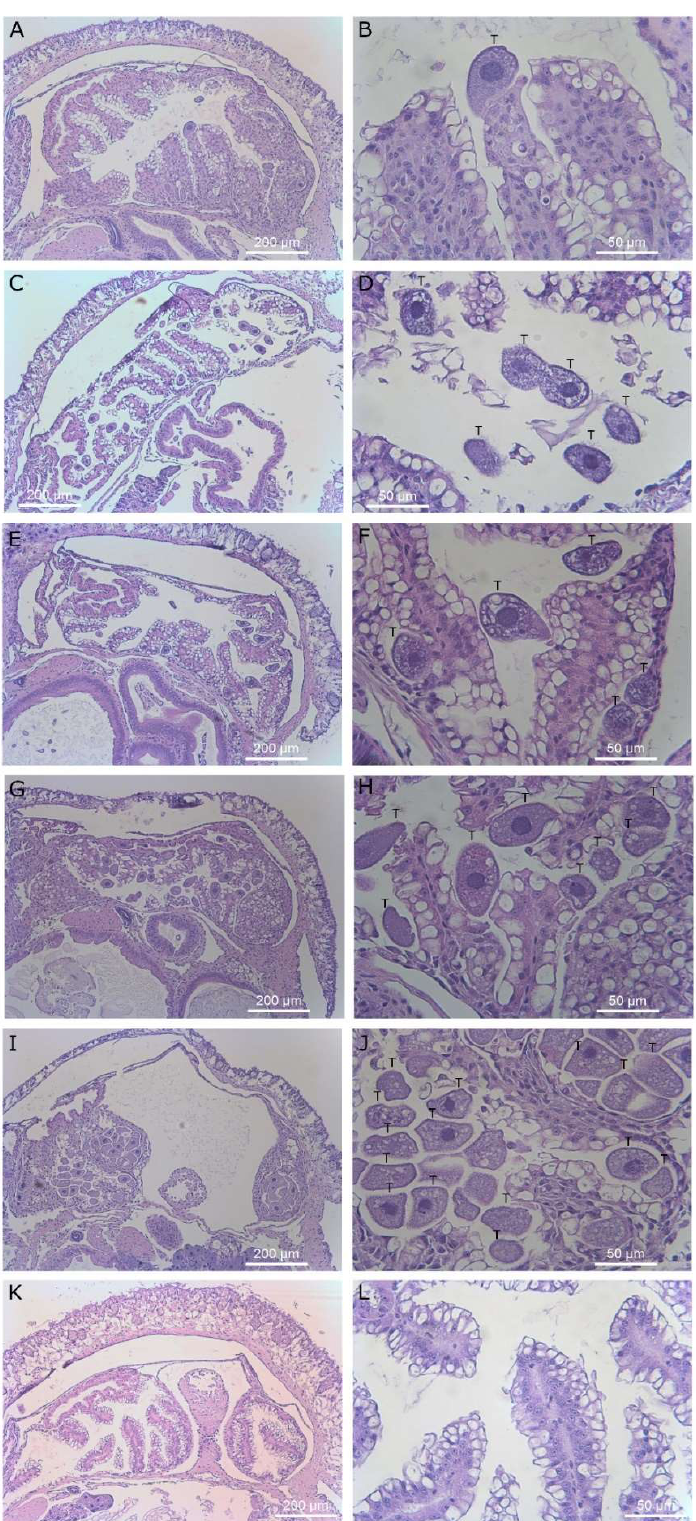
Figure 8. Histological sections of slug kidney. Magnification × 40 (left column) and × 400 (right column). Images ( A – H ) display slugs exposed to T. rostrata . ( A – H ) shows ciliates free swimming within the saccular portion of the kidney along with several ciliates encapsulated in granulomas and others grazing on vacuolar cells or encapsulated, ( I – L ) show the saccular portion of the kidney of a healthy control slug, showing healthy kidney structure. Ciliates are marked with a “T” above the cells in panels ( B , D , F , H , J ).